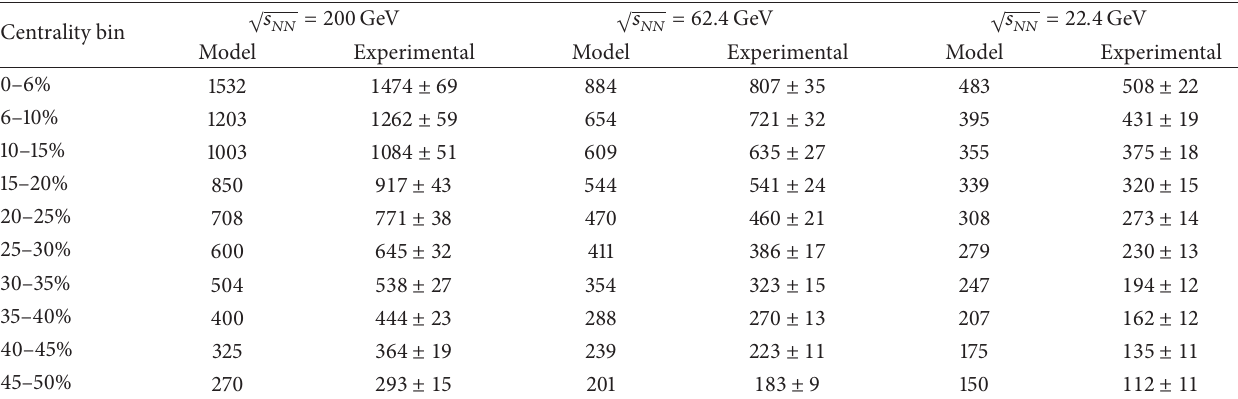
Table 2: The total charged hadron multiplicities as a function of centrality in Cu-Cu collisions at three different RHIC energies [41, 120]. Centrality